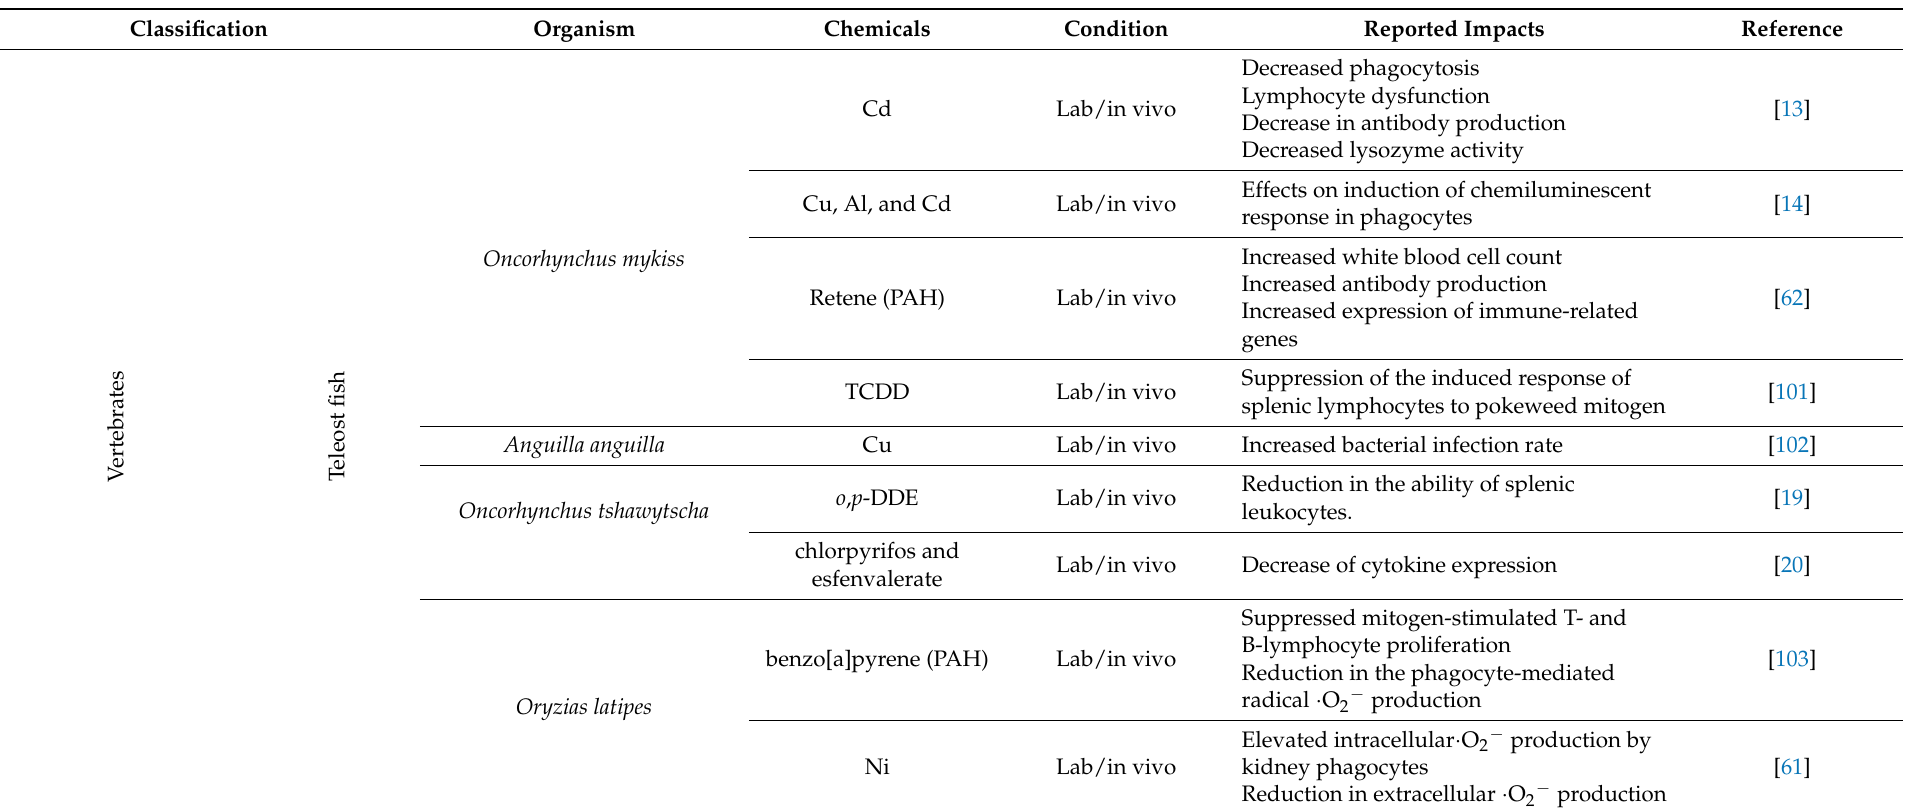
Table 2. Chemical substances that have been reported to have immunotoxic effects in teleost